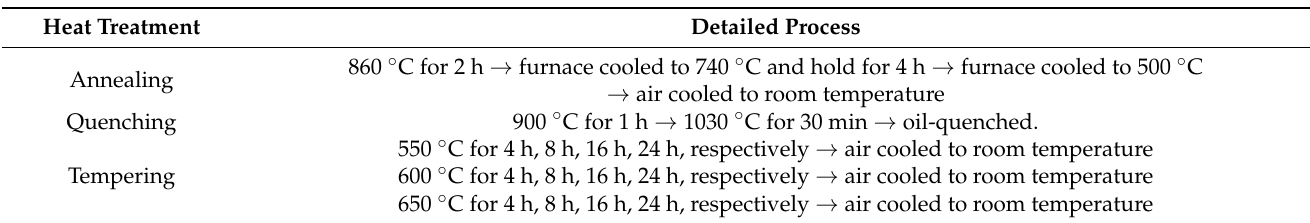
Table 2. The heat treatment